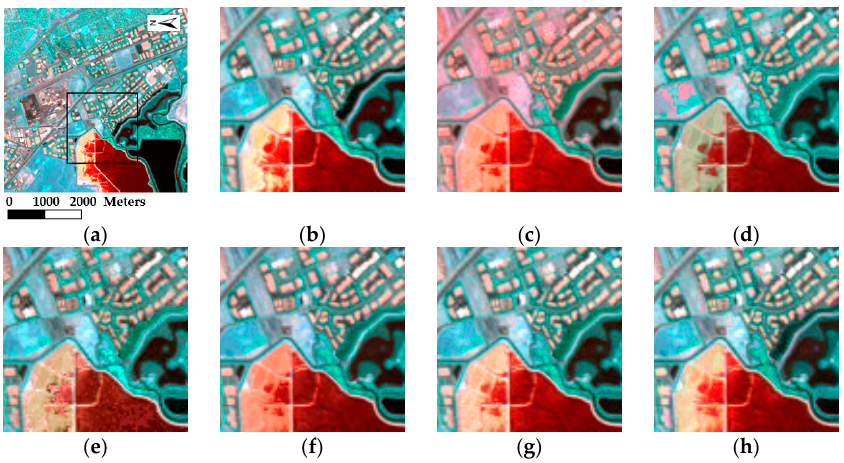
Figure 8. Comparison of fusion results on image Moffett-field with bands 30, 62, and 83 as red, green, and blue, respectively: ( a ) Moffett-field and the area-of-interest (black square); ( b ) original HR-HSI;